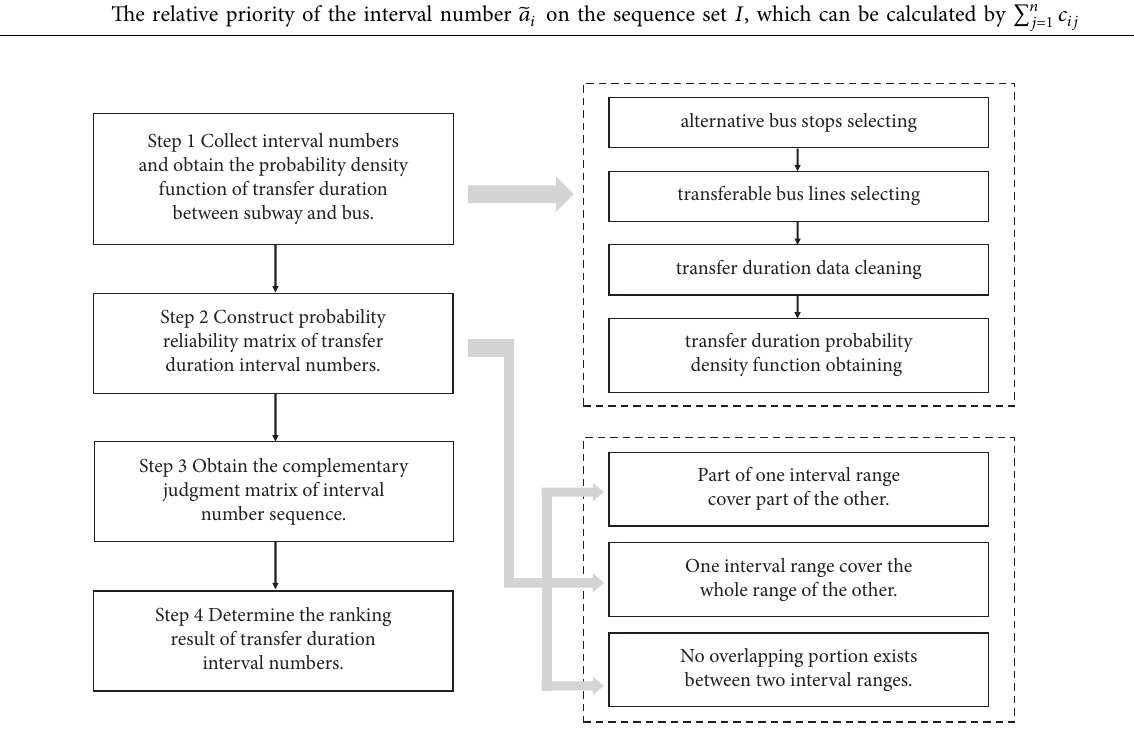
Figure 1: Interval number ranking method based on transfer time between subway and